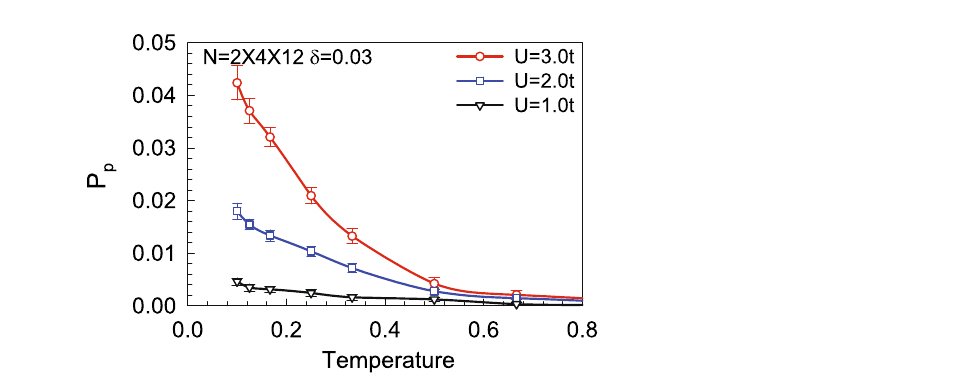
Figure 7. The effective p -type pairing interaction as a function of temperature on a lattice with 2 × 4 × 12 sites for different U at δ =